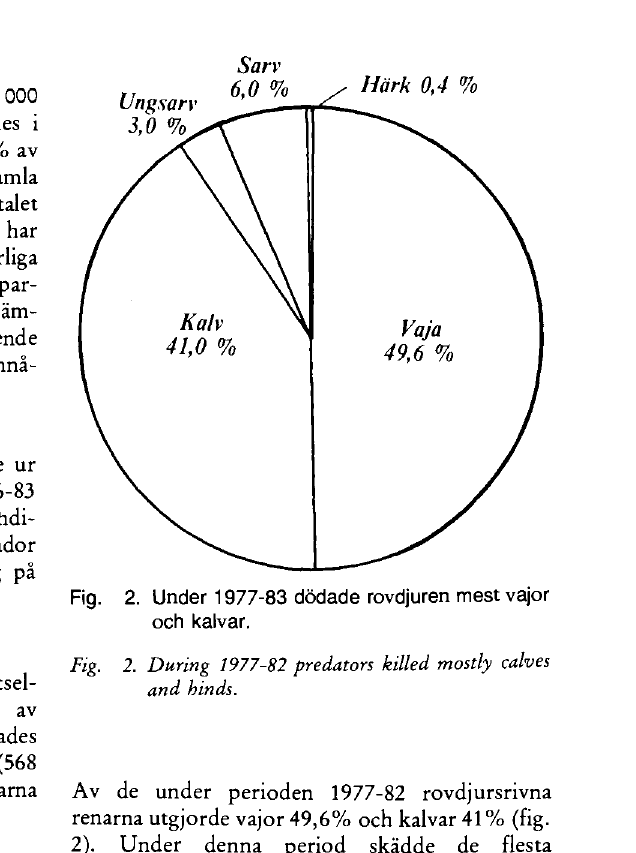
Fig. 2. Under 1977-83 dodade rovdjuren mest vajor och kalvar. Fig. 2. During 1977-82 predators killed mostly calves and